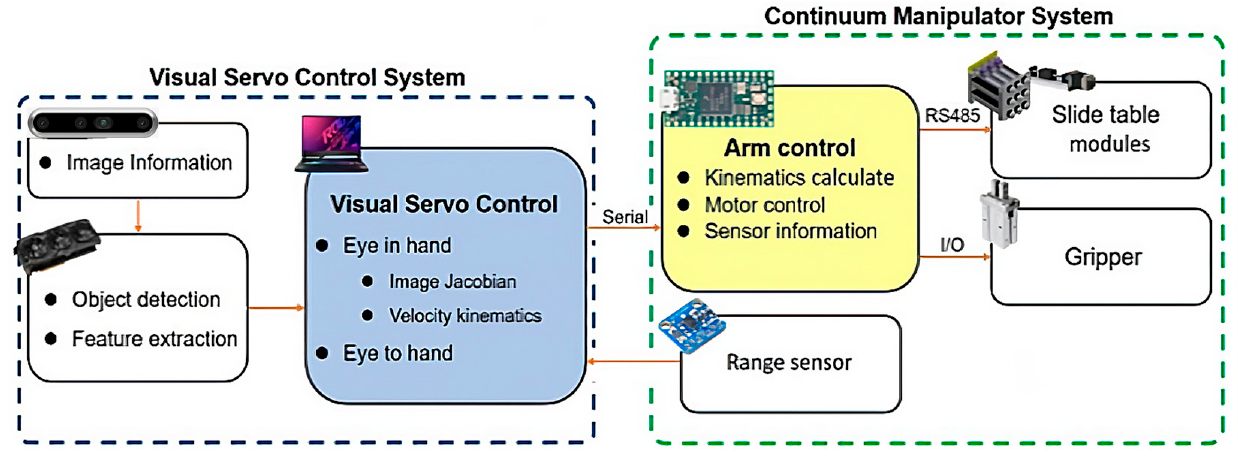
Figure 2. The overall architecture of the proposed visual servo continuum manipulator.